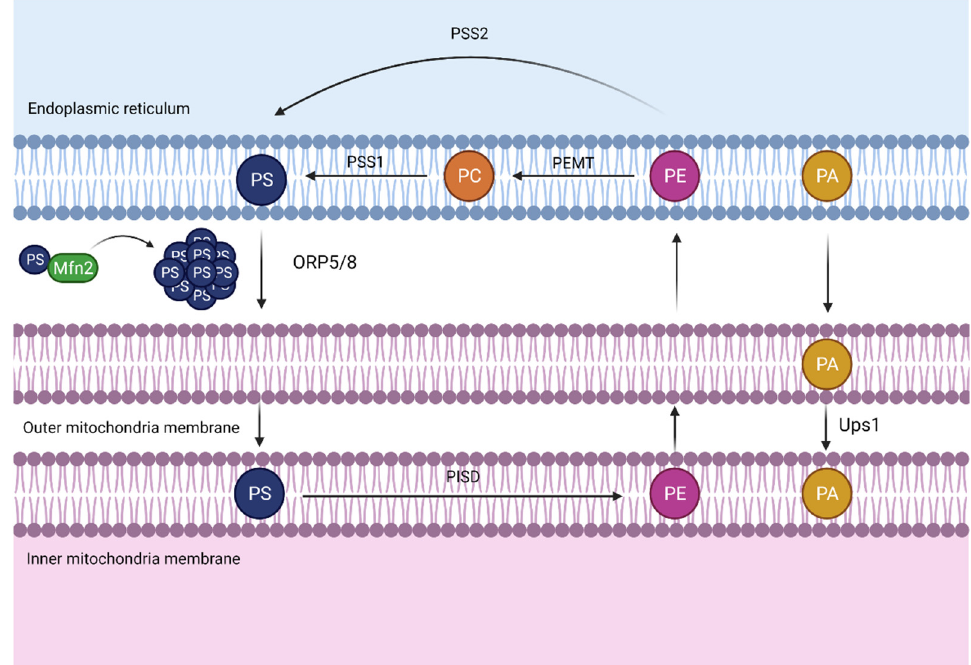
Figure 3. Mitochondria-associated membranes (MAMs). The close apposition between the endoplasmic reticulum (ER) and the mitochondria allows the transport of phosphatidylserine (PS) from the ER to mitochondria, where it can be converted into phosphatidylethanolamine (PE) and transported back to the ER. The PS transport is facilitated due to a mitochondrial outer membrane nucleotide guanosine triphosphate phosphatase (GTPase), mitofusin 2 (Mfn2), which elaborates rigid domains enriched in PS, hence, facilitating PS transport through oxysterol binding protein ‐ like 5/8 (ORP5/8). On the other hand, protein UPS1 mitochondrial (Ups1) transfers phosphatidic acid (PA) from the outer to the inner mitochondrial membrane. Abbreviations: PSS1, phosphatidylserine synthase 1; PSS2, phosphatidylserine synthase 2; PEMT, phosphatidylethanolamine N ‐ methyltransferase; PISD, phosphatidylserine decarboxylase proenzyme; PC, phosphatidylcholine.